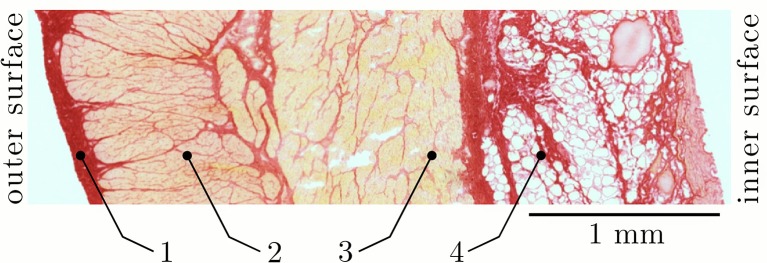
Section of a characteristic smooth tissue sample from porcine stomach. Representative picture from histological staining of samples from the proximal stomach (fundus) at 200% slack length (LS) in longitudinal direction. Four distinct layers can be identified: (1) tunica serosa, (2) longitudinal muscle layer (tunica muscularis), (3) transversal (circumferential) muscle layer (tunica muscularis), and (4) tela submucosa.